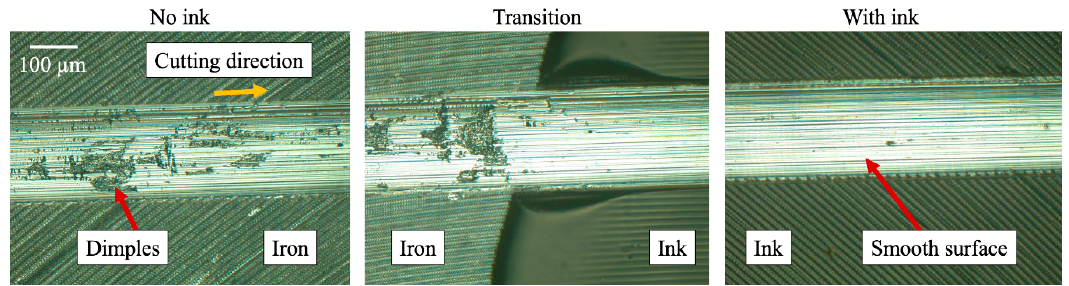
Figure 4. Optical imaging of the machined surfaces.